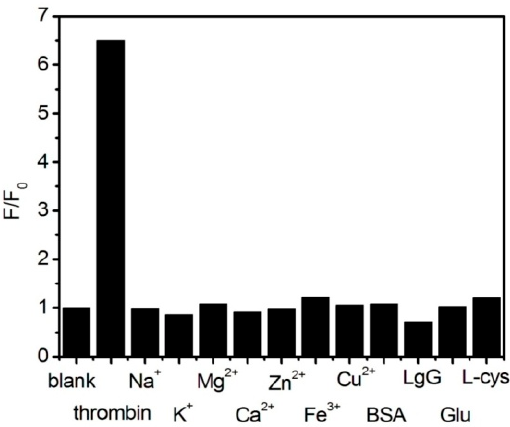
Figure 6. Fluorescence recovery of different substances in HEPES buffer (20 mM, pH 7.4). The concentration of all substances was 1 µ M. F 0 is fluorescence intensity at 545 nm for Pdots-BHQ-TBA, and F is the fluorescent intensity after adding different substances. Excitation was performed at 455 nm.